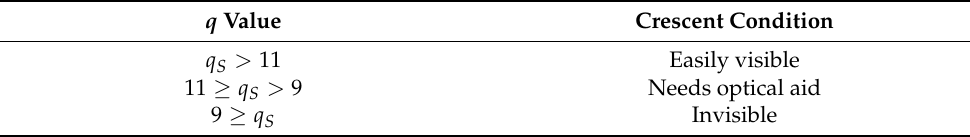
Table 3. Crescent Conditions for SAAO criterion [23]. q